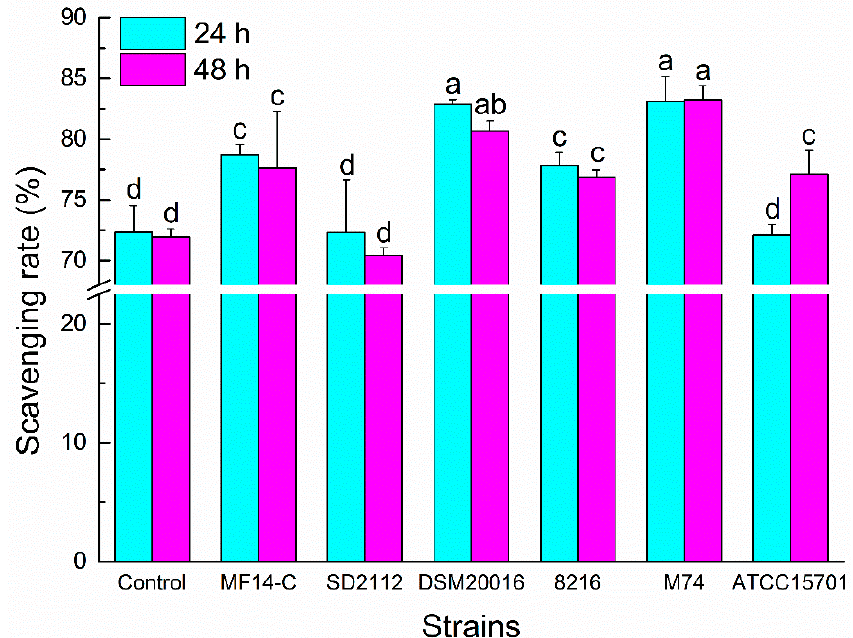
Figure 2. 3-ethylbenzothiazoline-6-sulfonic acid (ABTS + ) radical scavenging activity of PLSE fermented by six strains of probiotic bacteria at 37 °C for 24 h and 48 h. Different superscript small letters (a, b, c, and d) are significantly different ( P < 0.05).